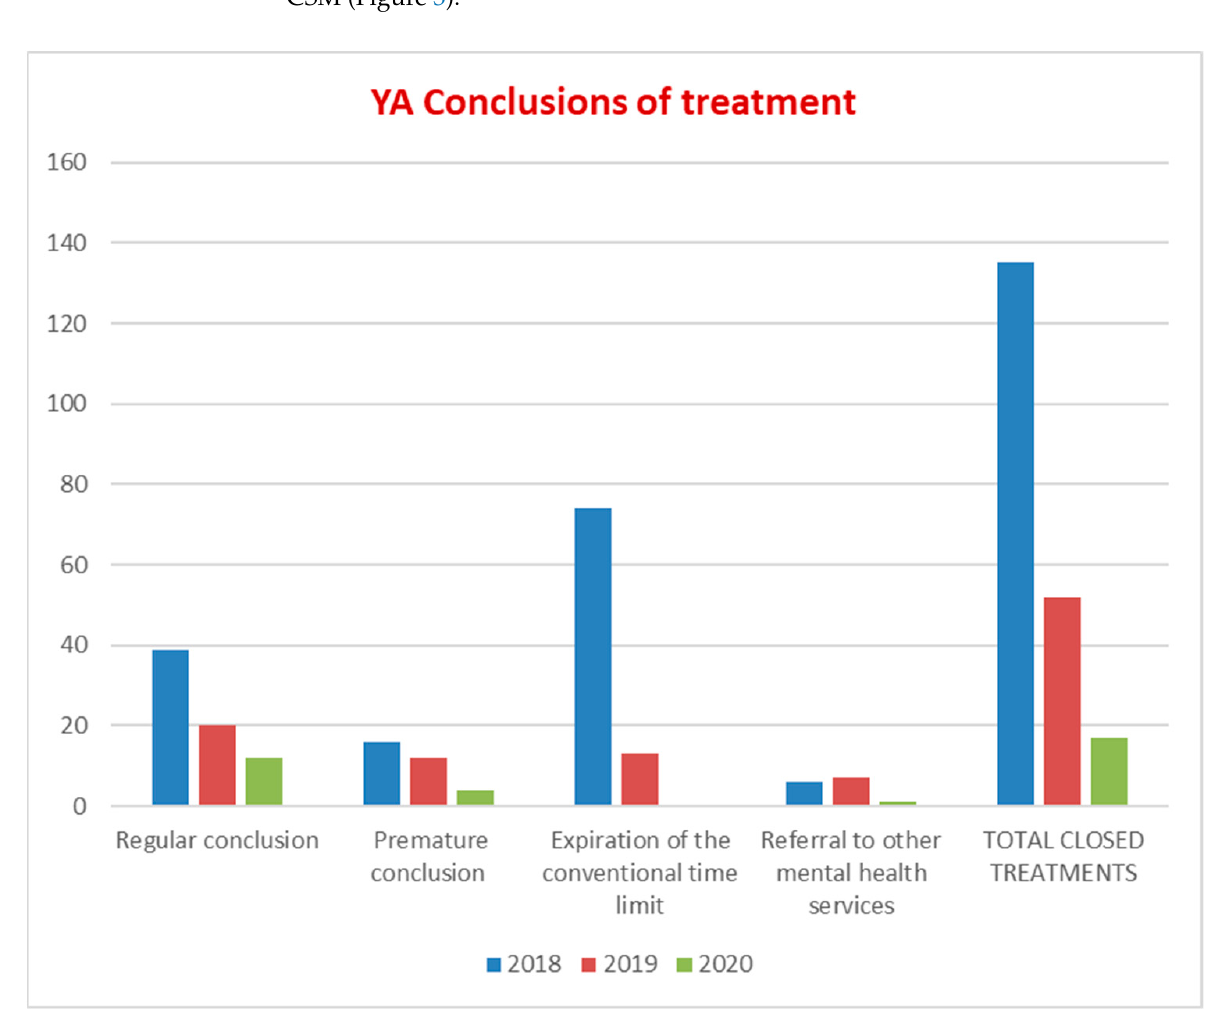
Figure 3. YA conclusions of treatment.